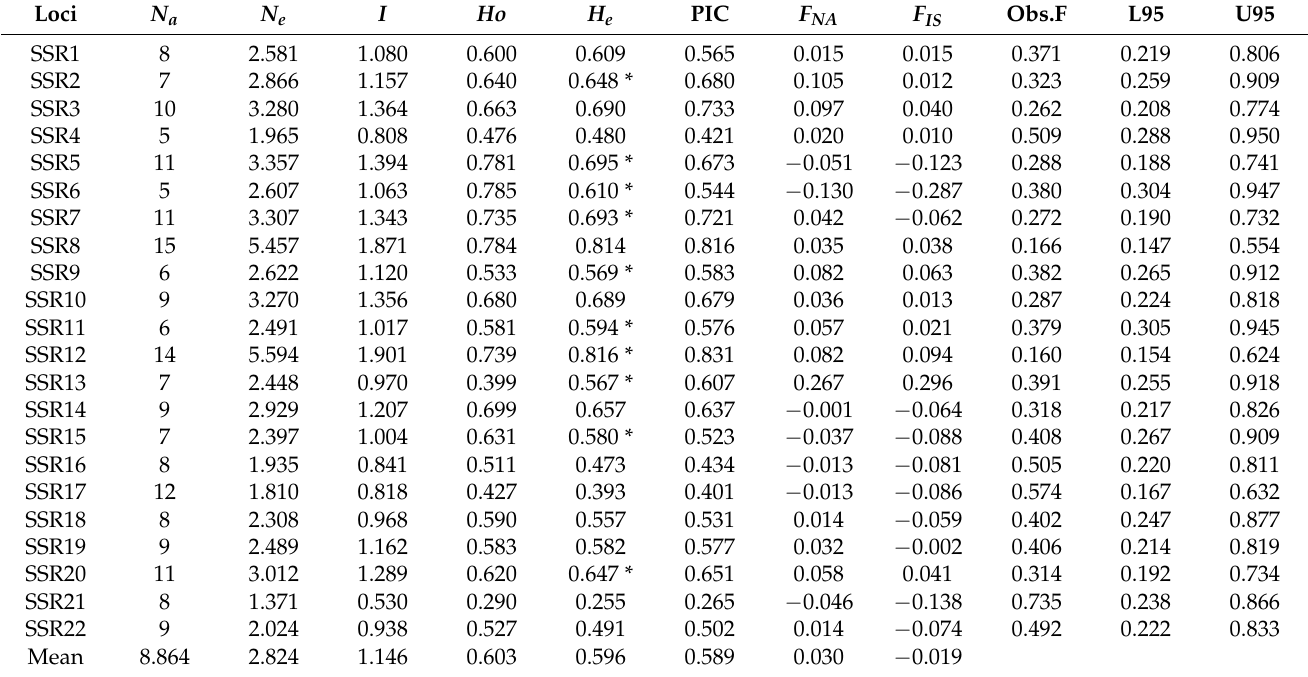
Table 3. Genetic parameters of 22 simple sequence repeat markers in all tested Chinese